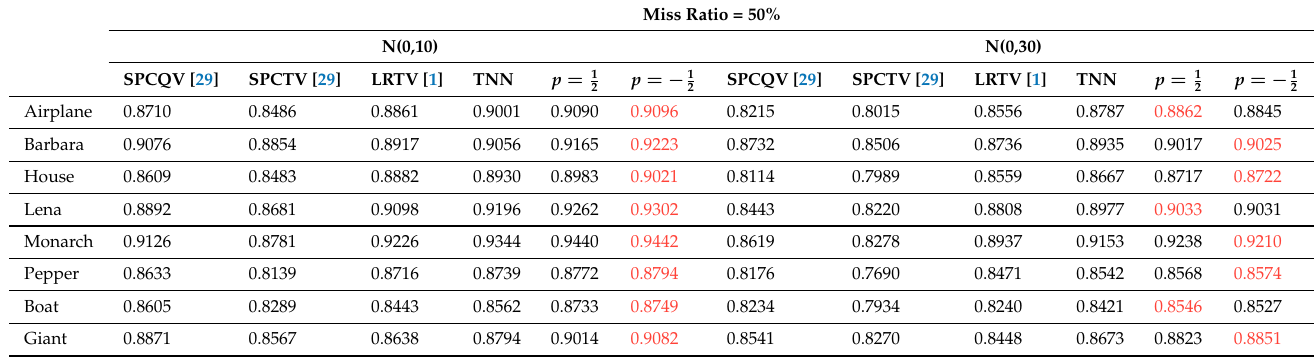
Table 4. Comparisons of SSIM for images with 50% missing elements, where red is the best